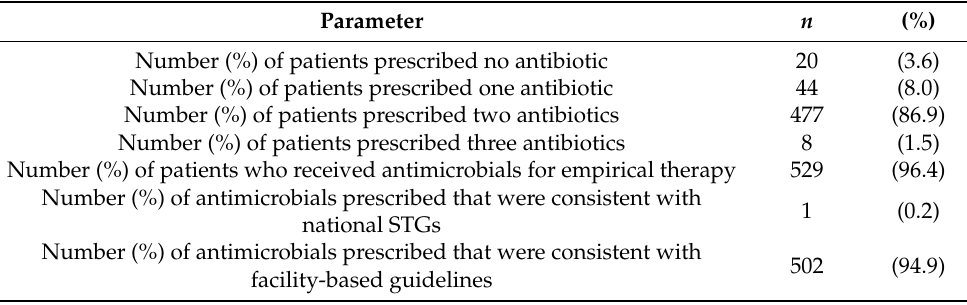
Table 4. Antimicrobial prescription practices and patterns among neonates admitted with suspected sepsis at Komfo Anokye Teaching Hospital, Ghana, between January 2021 and December